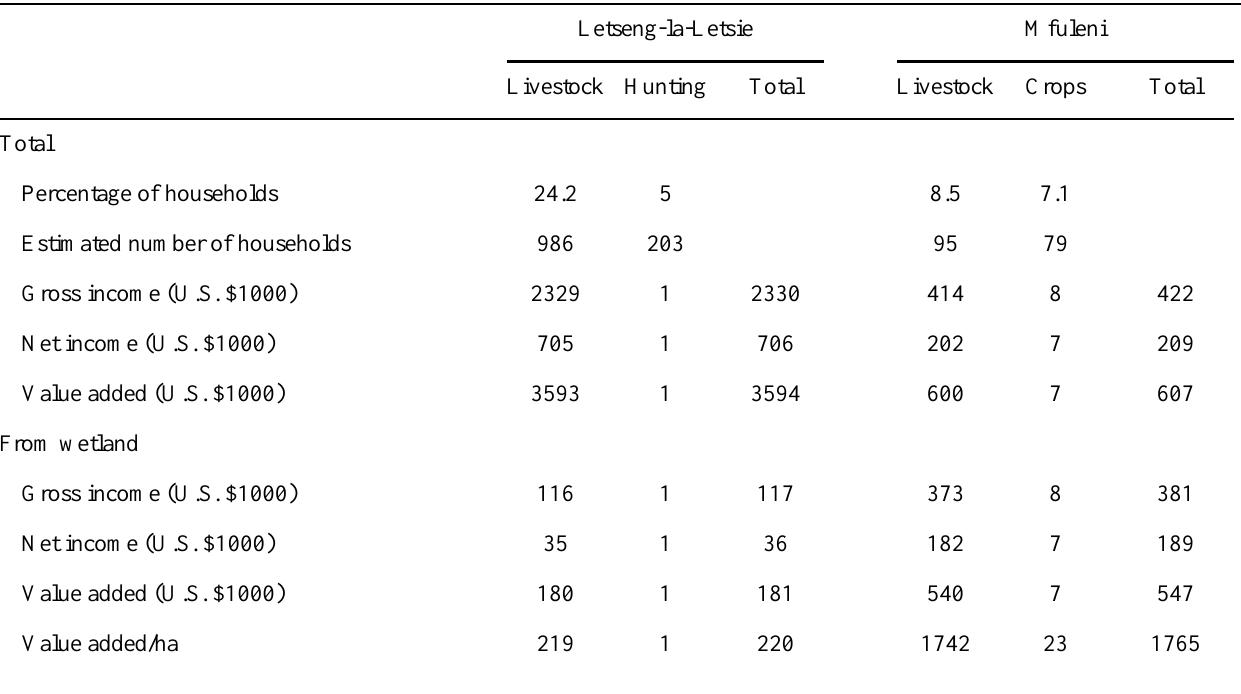
Table 7 . Estimated total incomes earned and incomes from wetland provisioning services for Letseng-la- Letsie (819 ha) and Mfuleni (310 ha). Letseng-la-Letsie Mfuleni Livestock Hunting Total Livestock Crops